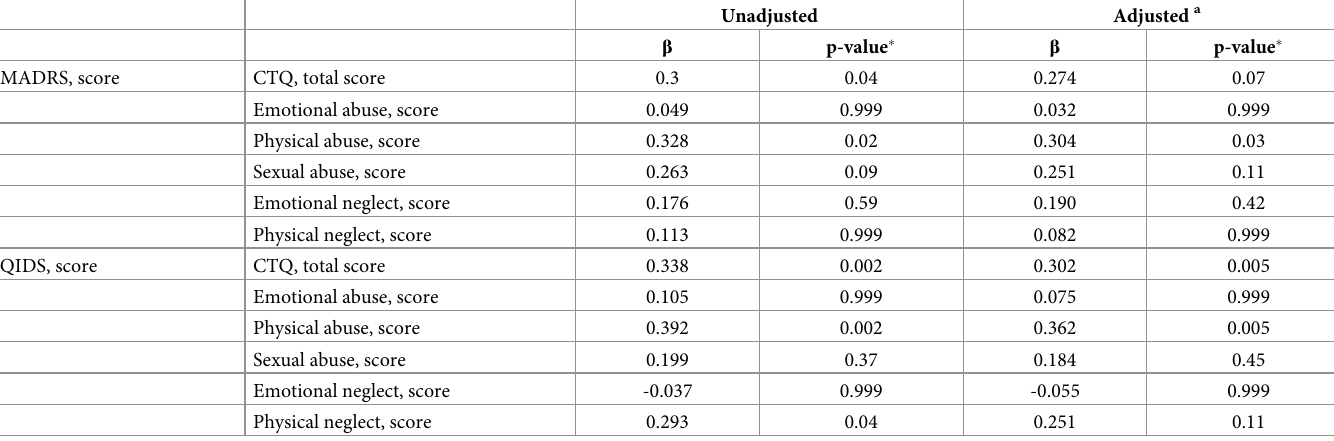
Table 3. Association between the intensity of depressive disorder and childhood trauma at baseline.